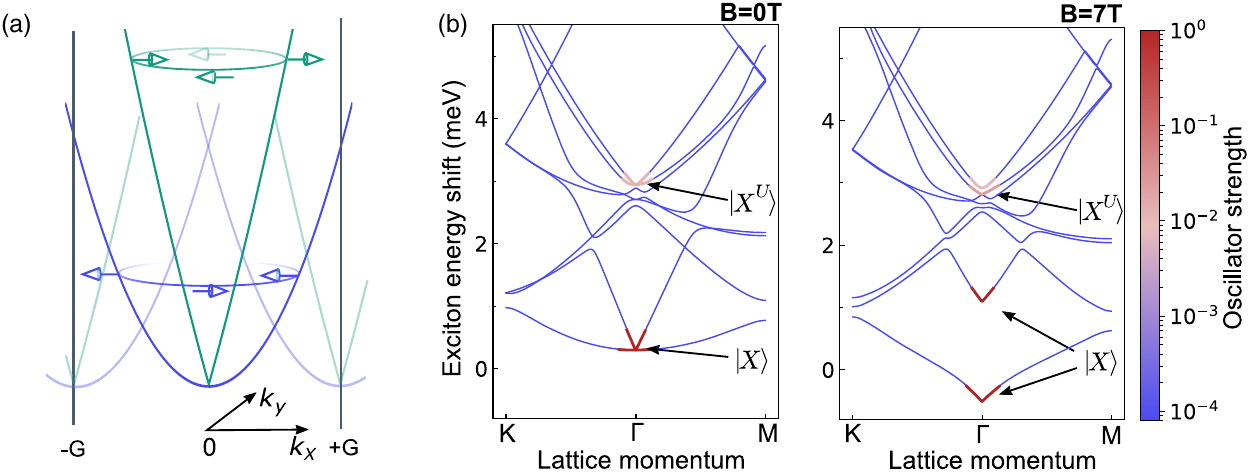
FIG. 4. Exciton band structure. Spectrum of the effective band Hamiltonian of Eq. (3) for parameters given in the main text and J ¼ 300 meV. (a) Bare dispersion of mobile excitons. Strong intervalley electron-hole exchange coupling splits the linearly polarized exciton modes and yields two branches with linear (green line) and parabolic (blue line) dispersion. For simplicity, we do not show that the degeneracy of the excitonic branches extends throughout the light cone. The exciton valley pseudospin is shown as blue (green) arrows for the parabolic (linear) dispersion. Periodic potentials allow states connected by reciprocal lattice vectors to mix, yielding higher bands (transparent lines), as shown in an extended zone scheme. Higher bands of the linearly dispersing mode decouple due to their large energy detuning. (b) Exciton bands along a path in a moir´e Brillouin zone. The oscillator strength of each state is indicated by the color bar, which is saturated for all blue lines. As photons carry almost vanishing momentum, only modes close to the Γ point may obtain finite oscillator strength (we artificially extend the momentum range of the bright states for better visibility). While most states remain dark, only a single umklapp band per polarization obtains sizable oscillator strength. Left: dispersion in the absence of a magnetic field. We find an energy splitting between the umklapp state and the main resonance of 3 meV. This additional bright state carries 1.2% of the oscillator strength of the bare exciton. The oscillator strength of higher bands is significantly suppressed due to the ¼ 7 T. While the main resonance splits larger energy splitting, which reduces the coupling to light. Right: exciton dispersion for B z significantly, the umklapp peaks are only marginally affected by the magnetic